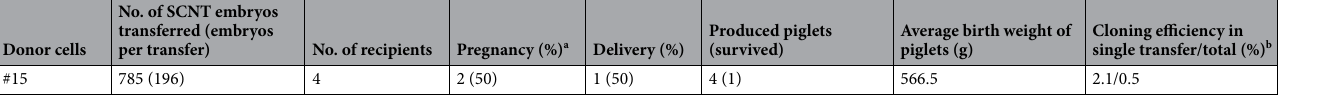
Table 1. In vivo developmental potential of somatic cell nuclear transfer (SCNT) embryos reconstructed using GTKO/CD55/CD39 transgenic donor cells. a Pregnant recipients/total recipients. b piglets/total embryos